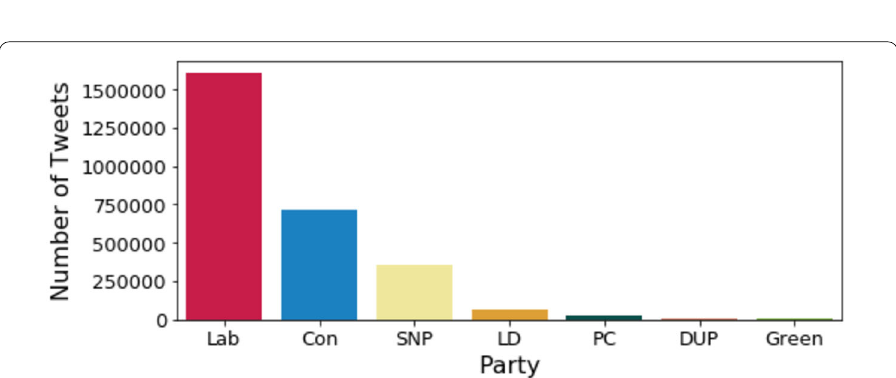
Figure 1 Top 7 parties by number of Commons Speeches in our dataset. Abbreviations denote: Con = Conservative, Lab = Labor, SNP = Scottish National Party, LD = Liberal Democrats, DUP = Democratic Unionist Party, Ind = Independent, PC = Plaid Cymru